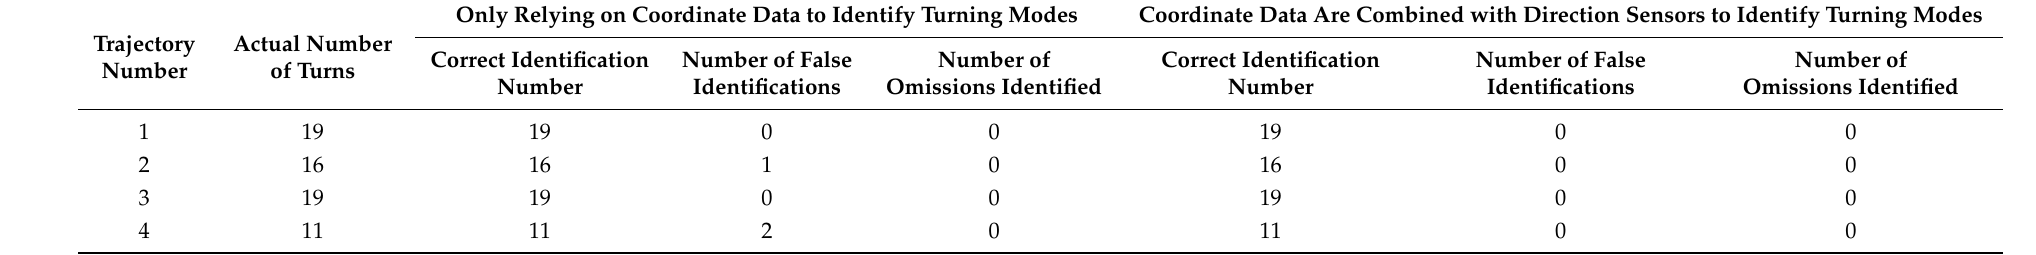
Table 3. Recognition accuracy of turning modes when the compression threshold is set to 5 m.